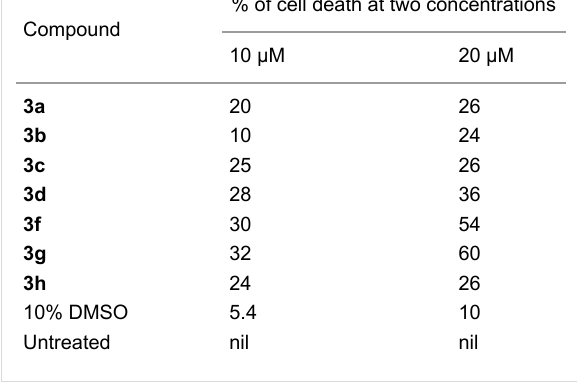
Table 3: Cytotoxic activity of 4-alkynylthieno[2,3- d ]pyrimidines ( 3 ) against chronic myelogenous leukemia (CML) cell line.